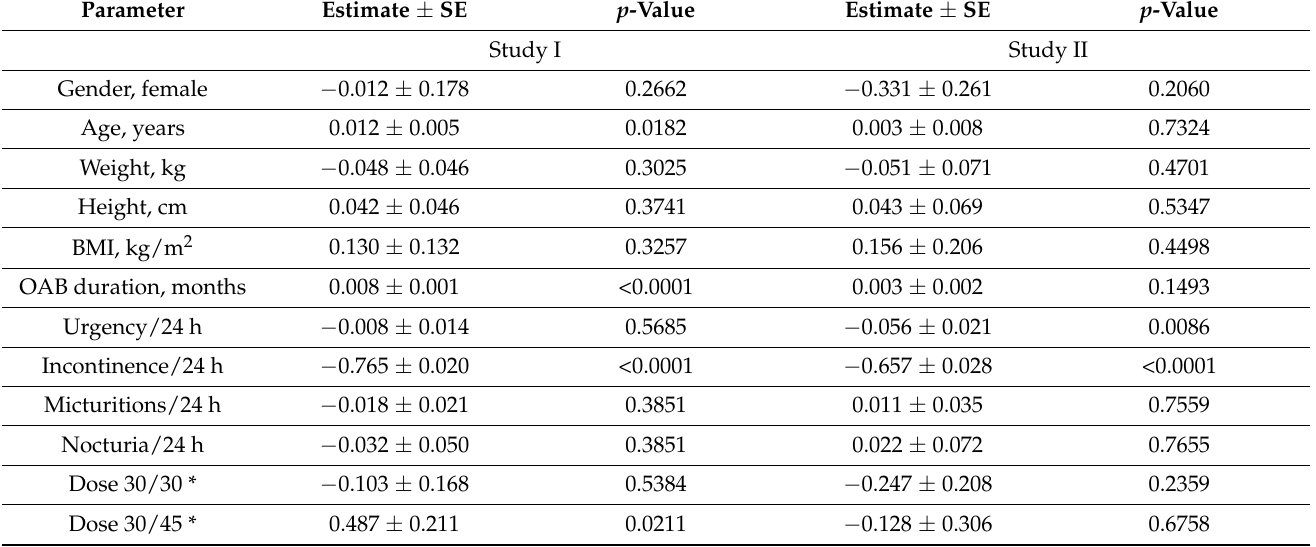
Table 6. Factors associated with overall improvement of incontinence (12 weeks vs. baseline) in a logistic regression analysis taking demographics, OAB parameters at baseline, duration of condition and dose level into